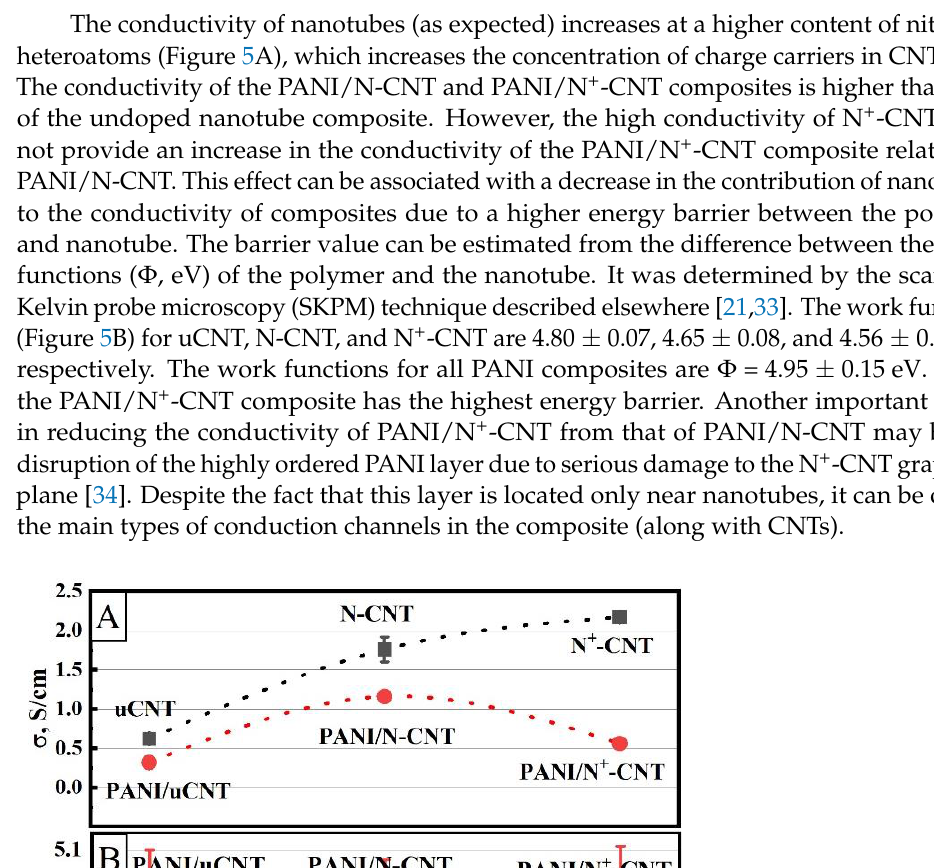
Figure 4. C1s NEXAFS spectra of PANI/uCNT, PANI/N-CNT and PANI/N + -CNT.